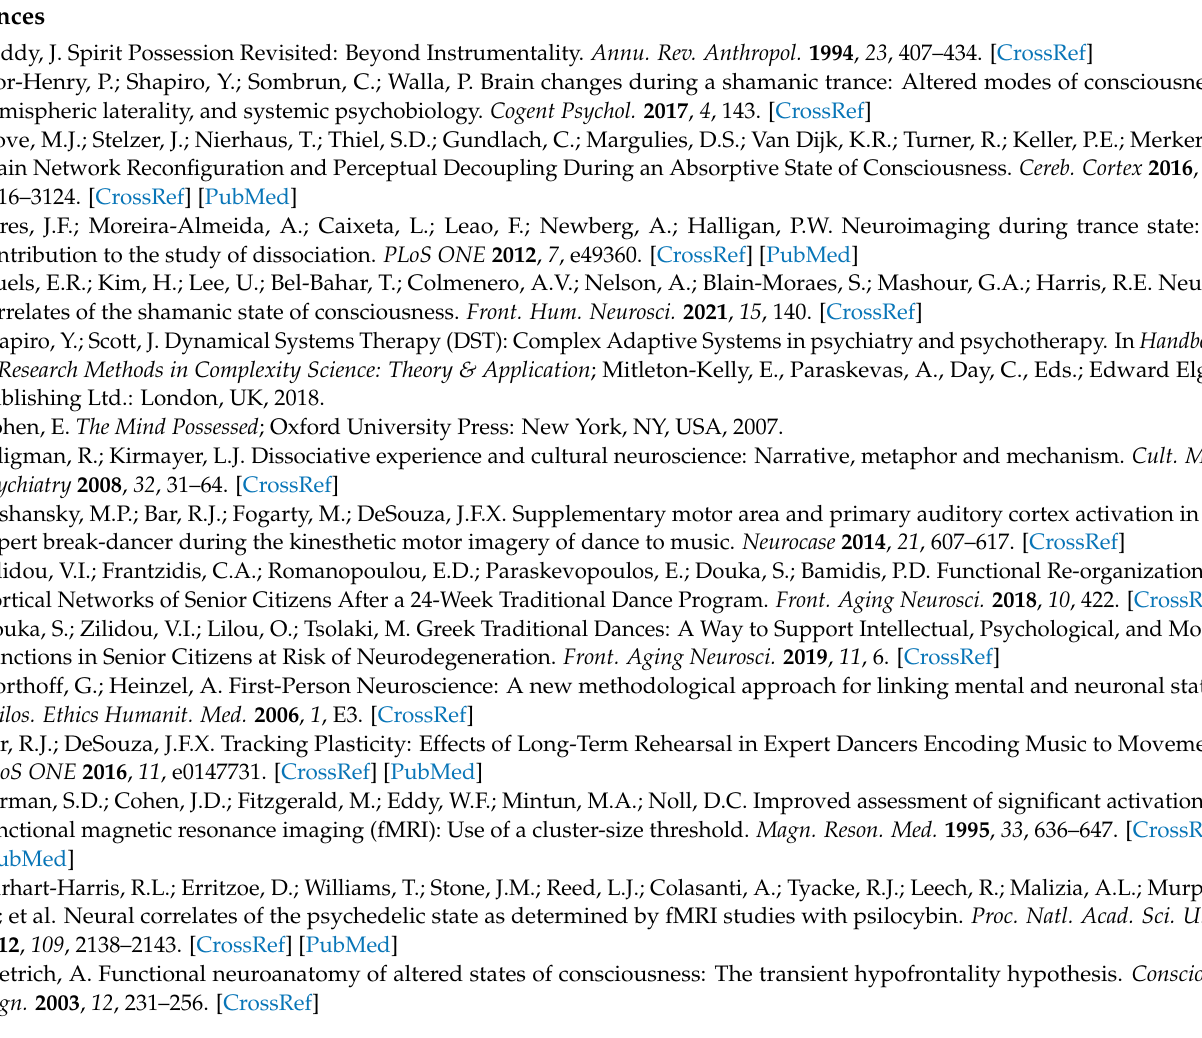
Figure A1. Orbitofrontal cortex (OFC) brain activation showing modulation of the Default Mode Network at volume time (141). When the subject’s perception of trance was HIGH, this OFC region changes from Default Mode Network (DMN) activity to being shut off from volume time (141 to end). This suggests an interaction between the DMN and trance with the perception of trance. This perceptual change in our subject is conceptually similar to the perceptual change of aura during migraine [40] in which 3 subjects perceived visual transients due to cortical